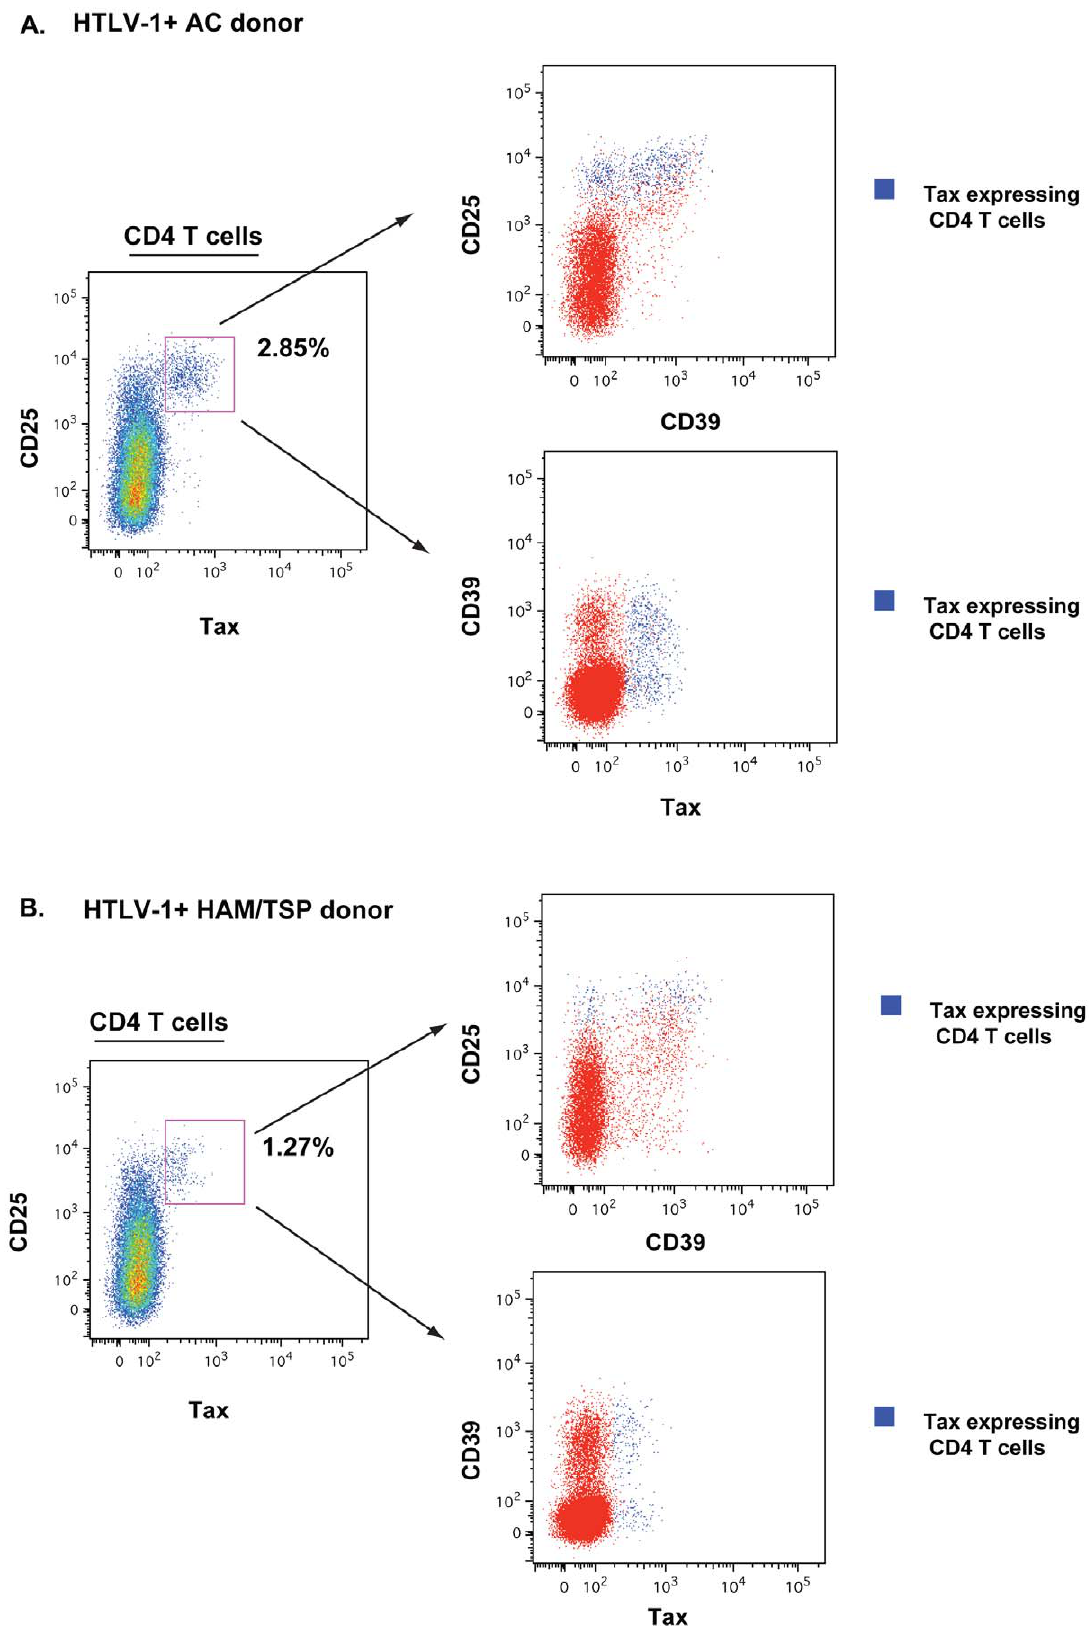
Figure 7. Tax expression in CD4 + T cells of HTLV-1-infected subjects. Representative flow cytometry data of CD25, CD39 and Tax expression in (A) one HTLV-1-infected asymptomatic carrier and (B) one HAM/TSP patient. Plots show Tax expression restricted to CD25 + CD4 + T cells regardless of CD39 expression. doi:10.1371/journal.pntd.0002028.g007 PLOS Neglected Tropical Diseases |